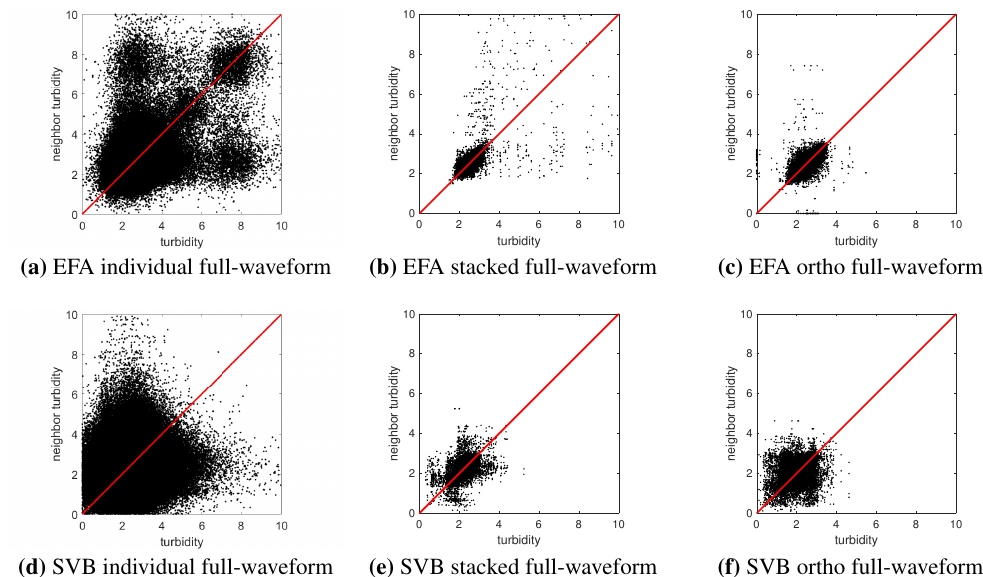
Figure 11. Scatter plot of adjacent decay coefficients.